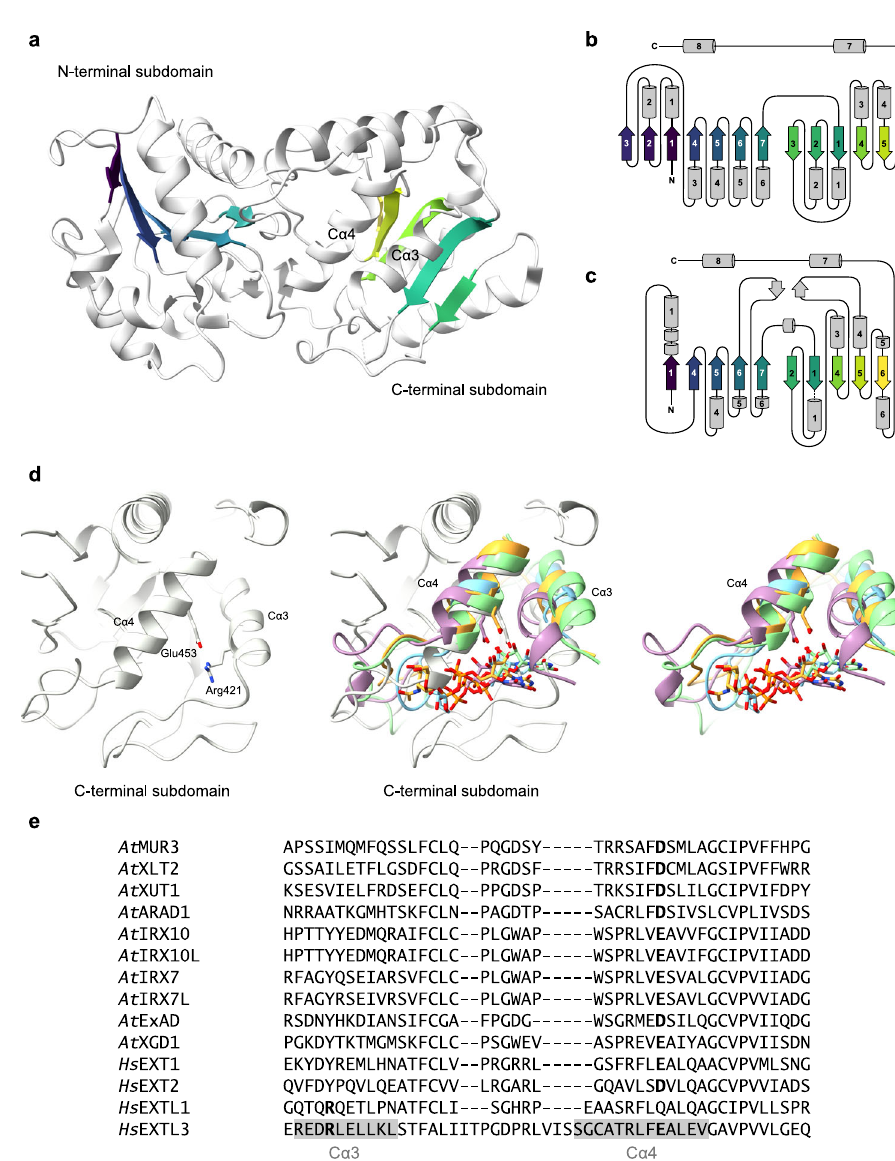
Fig. 5 The EXTL3 GT47 domain adopts a GT-B fold but appears to lack an appropriate nucleotide sugar binding pocket. a EXTL3 GT47 domain (from one individual chain). Strands in the central sheets are coloured purple to yellow in order of most N-terminal to most C-terminal. b Secondary structure schematic of a generic GT-B-fold glycosyltransferase. c Secondary structure schematic of EXTL3 GT47 domain, showing correspondence of the central strands to the GT-B archetype. d Structural alignment of the EXTL3 GT47 domain to the closest four GT-B matches from PDB25 identi fi ed using DALI (omitting duplicate family members). Left: C-terminal subdomain of EXTL3 GT47 domain (focussing on the C α 3 and C α 4 helices); right: hits from DALI without EXTL3 (only C α 3 – C α 4 portion shown for clarity); centre: merged. Structures, by PDB accession and GT family, from highest to lowest match are: 5F84 (GT90; pale blue), 1IXY (GT63; purple), 4W6Q (GT113; pale green), 6EJI (GT4; orange). e Protein sequence alignment of EXTL3 GT47 domain with other GT47 domain-containing proteins from Homo sapiens and Arabidopsis thaliana (only the C α 3 – C α 4 portion is shown for brevity). Arg421 and Glu453 residues from EXTL3, as well as their analogues in other GT47 sequences, are highlighted in bold; the positions of the C α 3 and C α 4 helices in the EXTL3 sequence are highlighted in pale